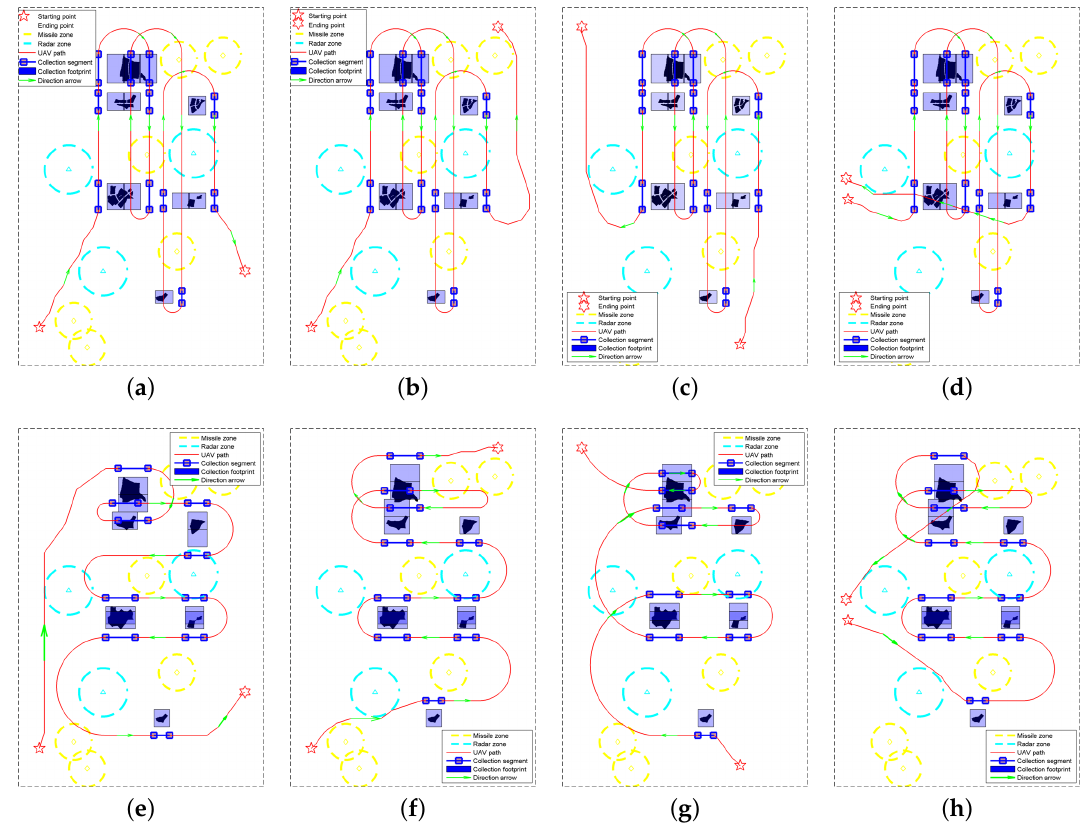
Figure 19. Vertical (top) and horizontal (bottom) zigzag paths. ( a,e ) test case 1; ( b , f ) test case 2; ( c , g ) test case 3; ( d , h ) test case